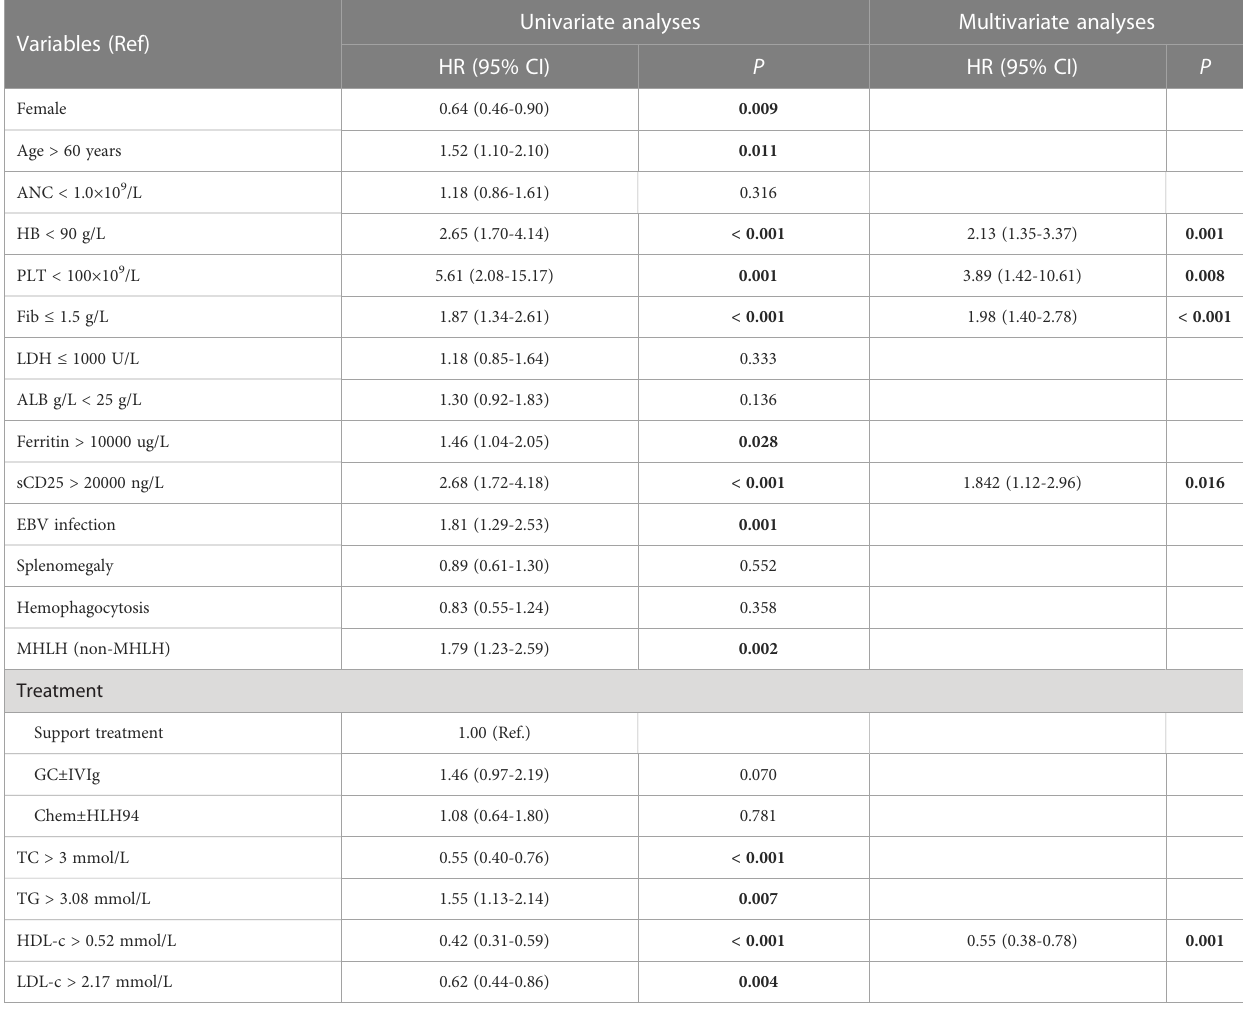
TABLE 2 Univariate and multivariate analysis of predictors for overall survival in 247 patients with sHLH.